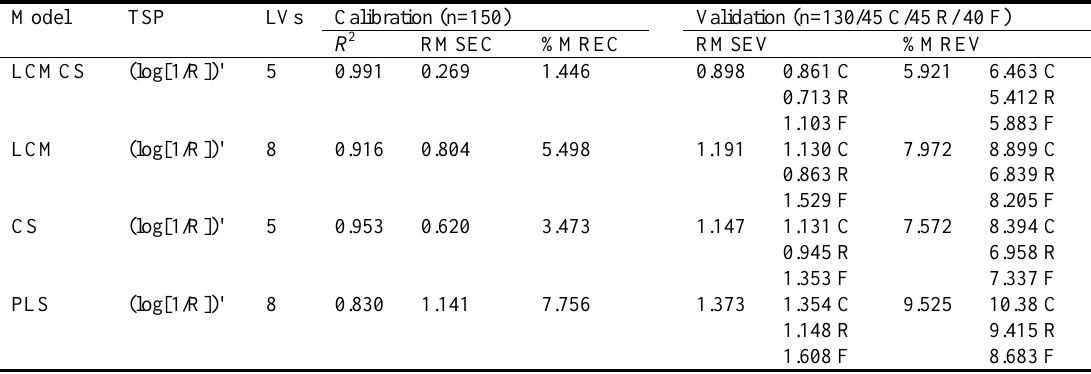
Table 4. Test result of the local correlation maximization-complementary superiority method (LCMCS), complementary superiority (CS), local correlation maximization (LCM) and partial least squares regression (PLS) models for total soil nitrogen (TN)